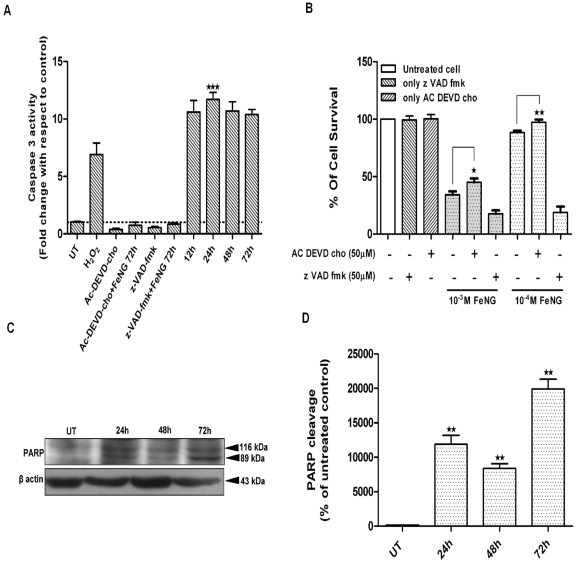
Activation of caspase 3 in CEM/ADR5000 cells after FeNG treatment.(A) Effect of FeNG and caspase inhibitors on the activity of caspase-3 of CEM/ADR5000 cells. Cells were treated with either vehicle (medium) control or FeNG (10−4 M) for 12 h, 24 h, 48 h, 72 h or caspases inhibitors; Ac-DEVD-cho (caspase 3 specific inhibitor) and z-VAD-fmk (pan caspase inhibitor) alone (50 µM) or in combination with FeNG for 72 h. After completion of these treatments, cells were harvested and cell lysates were prepared. The enzymatic activity of cell lysates towards tetrapeptide chromogenic substrates Ac-DEVD-AMC was determined. Caspase activities are expressed as fold change of control and presented as mean±SD of three independent experiments. Differences between untreated control and FeNG treated cells are significant ***P<0.001, by unpaired Student's t test. (B) Effects of caspase inhibitor on FeNG induced cell death of CEM/ADR5000 cells. Cells were either left untreated or treated with FeNG (10−3 M or10−4 M) or Ac-DEVD-cho (50 µM) and z-VAD-fmk (50 µM) alone or in combination with FeNG for 72 h and cell death was monitored by MTT assay. Value represents the mean ± SD of three independent experiments with four replicates in each. Significant difference at *P<0.05, **P<0.01, respectively, from only FeNG treated cells. (C) Effect of FeNG on the cleavage patterns of PARP in CEM/ADR5000 cells. Cells were grown at standard culture conditions as mentioned in Materials and methods, and treated with FeNG (10−4 M) for 24 h to 72 h, and cell lysates were prepared. Immunoblot analysis was performed to identify the full (116 kDa) and cleaved (89 kDa) PARP using specific primary antibodies. Loading was checked by immunoblotting of β -actin. Bands were visualized by Lumi glow detection system. Data shown are representative of three independent experiments. (D) Densitometric quantitation of cleaved (89 kDa) frgments of PARP in the cytoplasm. Immunoreactive bands were quantitated and expressed as the ratio of each band density to corresponding loading control (β actin) band density and values were represented after normalization to untreated control.